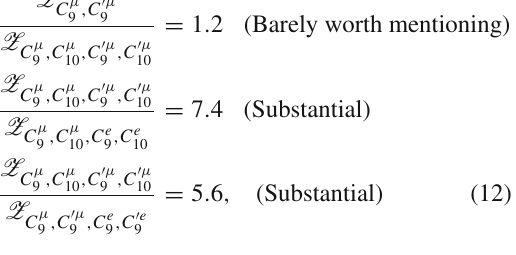
μ μ , C (third row of 9 10 μ μ (cid:4) μ (cid:4) μ , C , C , C all floating (fifth 9 10 9 10